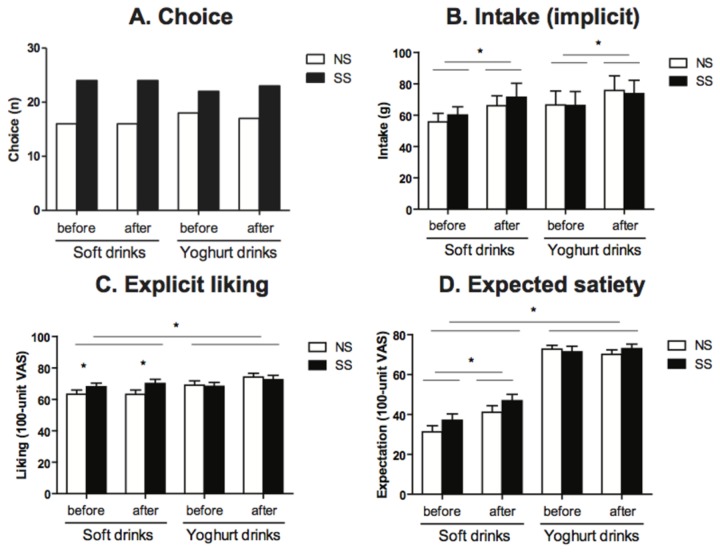
Results of the behavioral tasks for the NS (◻) and SS (◼) soft drinks and yoghurt dinks. (A) Choice: there was a main significant effect for sweetener type (p<0.05): the SS drinks were chosen more often than the NS drinks.(B) Total (implicit) intake (g): there was a main significant effect of time (p<0.05): intake was greater after the conditioning period than before. (C) Explicit liking: there was a main significant effect of drink type (p<0.01): the yoghurt drinks were more explicitly liked than the soft drinks. There was a significant interaction between drink type and sweetener type: the SS soft drink was more liked than the NS soft drink (p<0.05). (D) Expected satiety: there was a significant main effect of drink type (p<0.0001): the yoghurts drinks were expected to be more satiating than the soft drinks. There was a significant interaction between drink type and time (p<0.01): after the conditioning period the soft drinks were rated as more satiating. Values are means ± SEMs (n=40). For the choice tasks chi-squared analyses were performed. All others were analyzed by means of ANOVA (mixed model procedure).